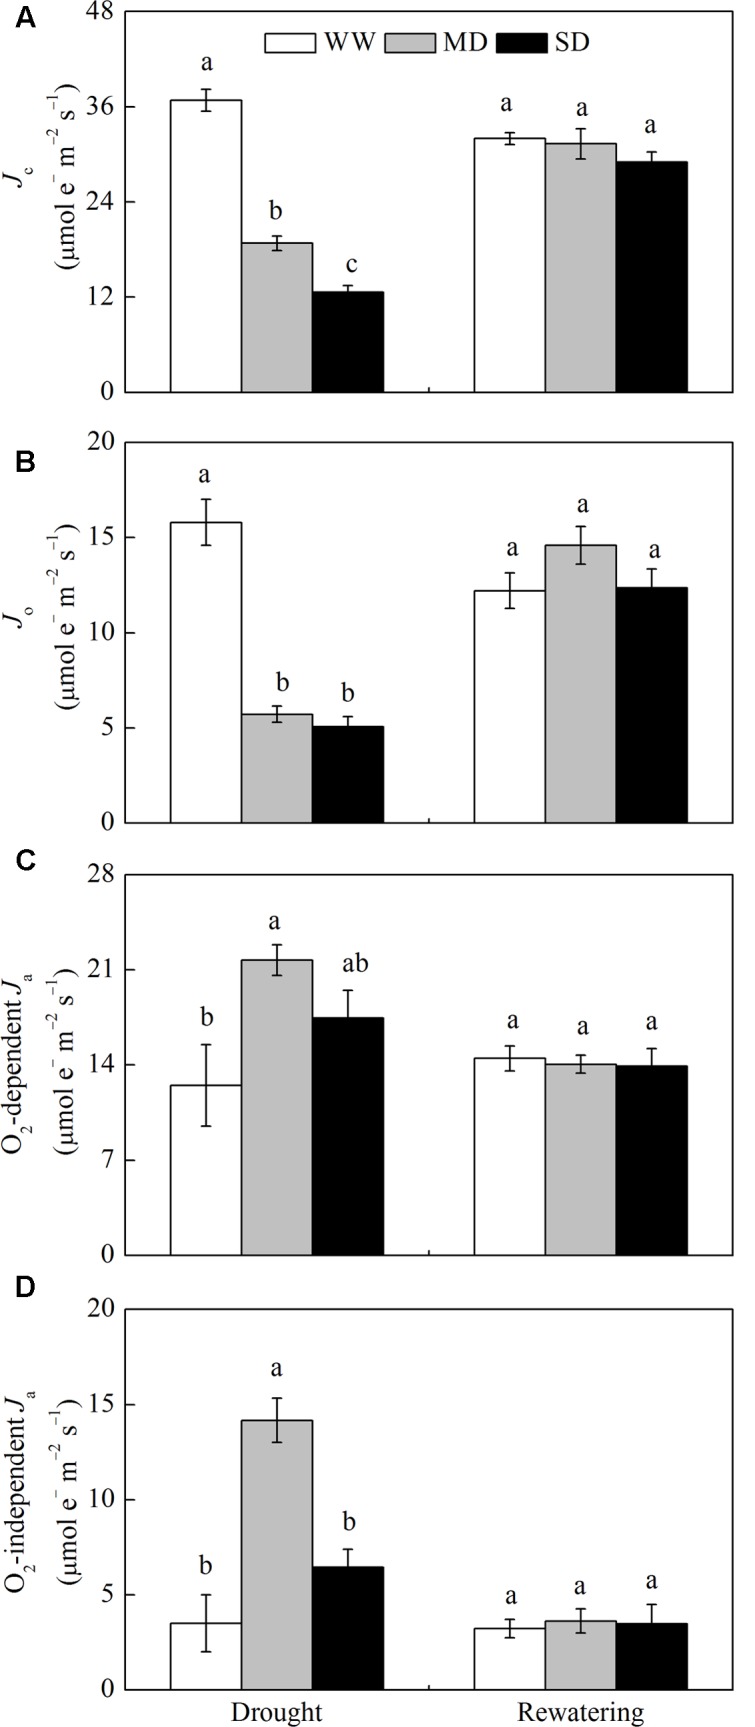
Changes in the flux of electron transport via different proportions of linear electron transport in PSII (JPSII) of F. rufa plants under drought and rewatering. (A) electron flux for photosynthetic carbon reduction Jc, (B) electron flux for photorespiratory carbon oxidation Jo, (C) O2-dependent alternative electron flux (O2-dependent Ja), and (D) O2-independent alternative electron flux (O2-independent Ja). Well-watered (WW, open bars), moderate drought (MD, gray bars), and severe drought (SD, closed bars). Data are the means of four replicates with SE shown by vertical bars. Different letters within the same stage indicate significant differences (P < 0.05) according to Duncan’s test.